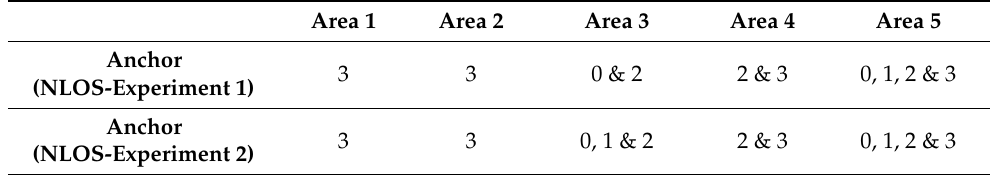
Table 1. Anchors in NLOS in different Areas.